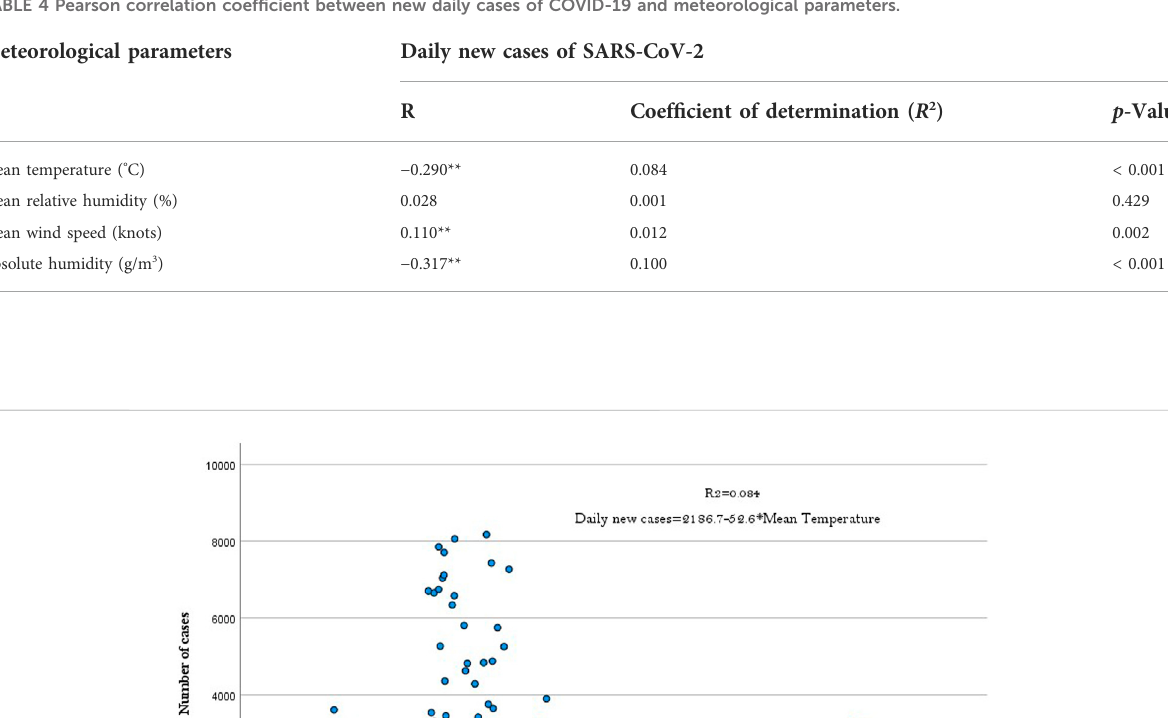
TABLE 4 Pearson correlation coef fi cient between new daily cases of COVID-19 and meteorological parameters.